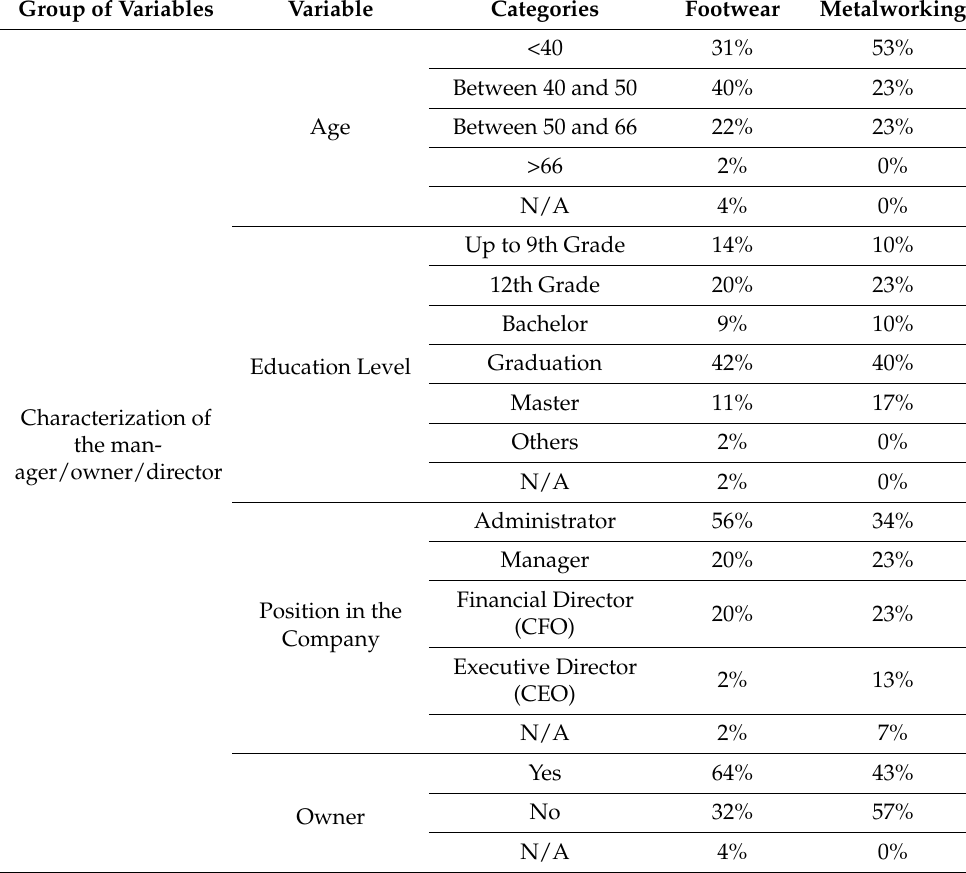
Table 2. Descriptive characteristics of the